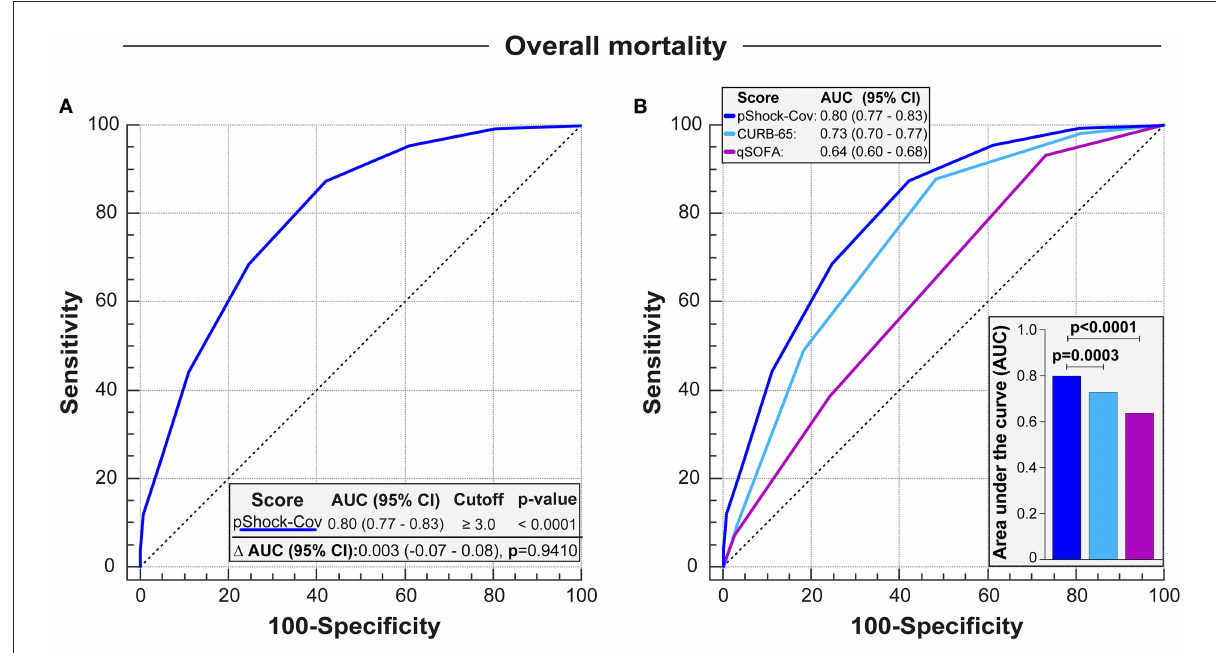
FIGURE3 Discrimation of pShock-CoV in critically ill patients with SARS-CoV-2 infection and comparison with other severity models. (A) Receiver operating characteristic (ROC) curve analysis of pShock-CoV for prediction of ICU mortality in the ICU original sample and comparison of area under the ROC curve ( 1 AUC) with pShock in the derivation cohort. (B) Overlap between ROC curves showing pShock-CoV performance and comparing with CURB-65 and qSOFA in COVID patients. Differences between AUC-ROCS were accessed by the DeLong